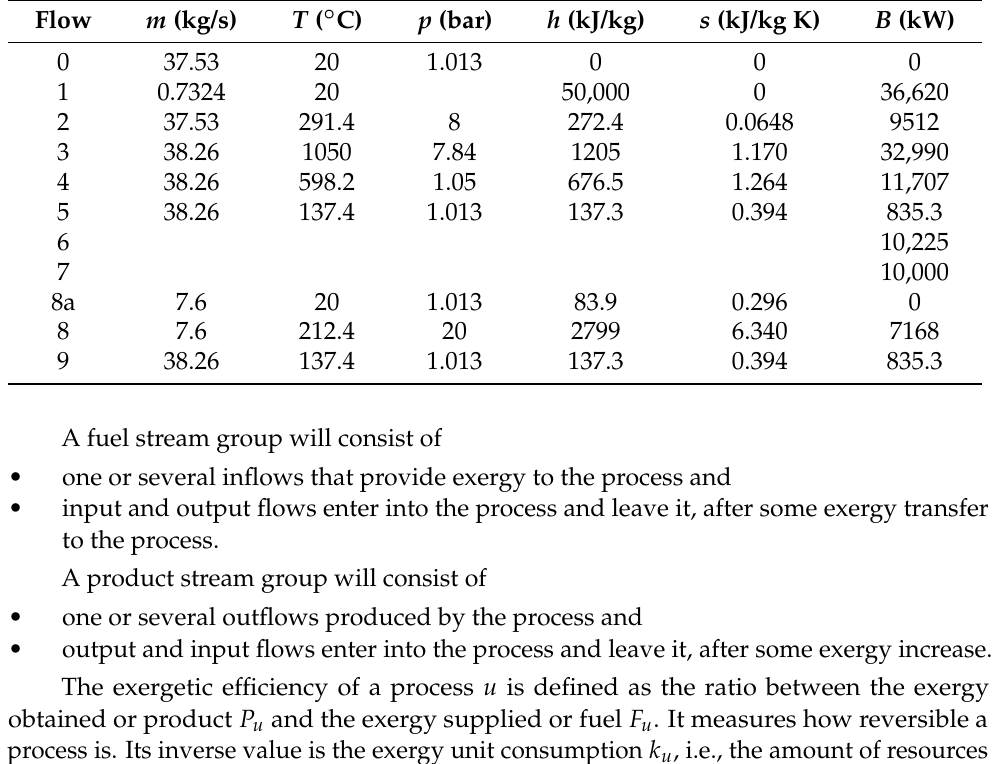
Table 1. Thermodynamic properties of TGAS case study.